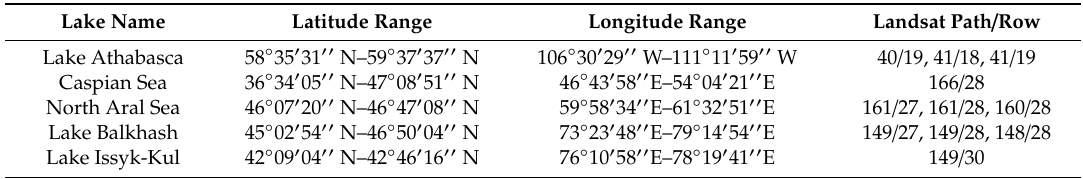
Table 1. Description of selected Landsat imagery scenes of the five lakes including: Lake Athabasca, Caspian Sea, North Aral Sea, Lake Balkhash and Lake Issyk-Kul.